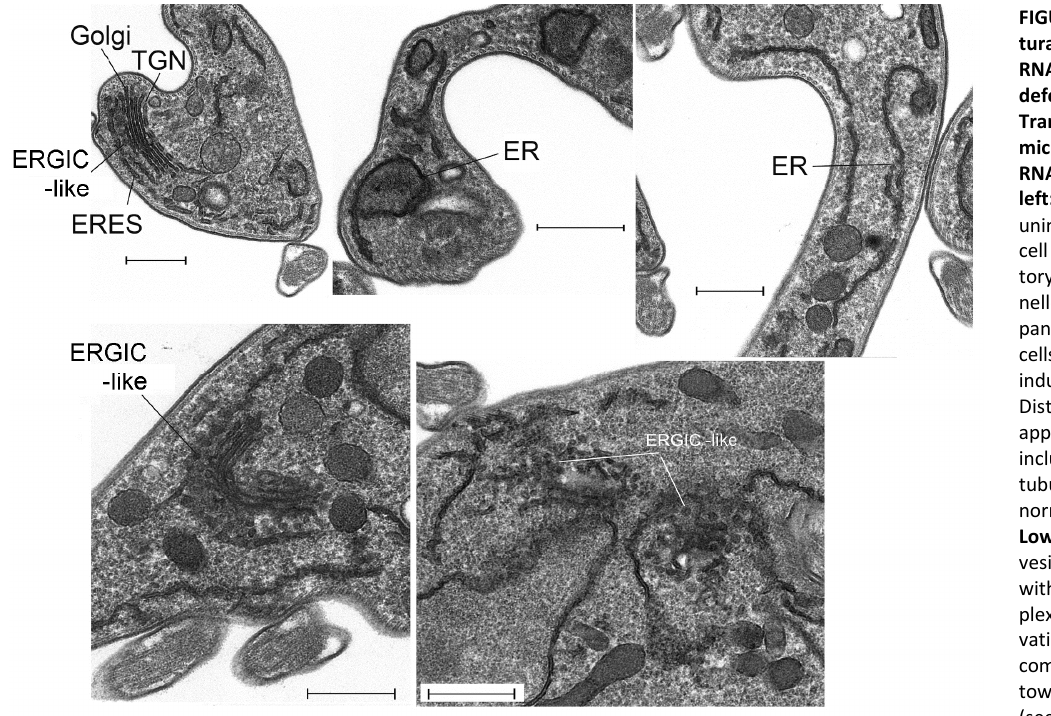
FIGURE 10: Ultrastruc- tural analysis of IGP48 RNAi cells reveals defects in the ER. Transmission electron micrographs of IGP48 RNAi cell lines. Top left: Representative uninduced IGP48 RNAi cell with major secre- tory pathway orga- nelles indicated. Other panels are induced cells after 24 hours induction. Top centre: Distorted ER with apparent lumenal inclusion. Top right: ER tubules with apparent normal morphology. Lower left: Extensive vesicles associated with the Golgi com- plex. Based on obser- vations that the Golgi complex is concave towards the trans- face (see top left panel), these vesicles